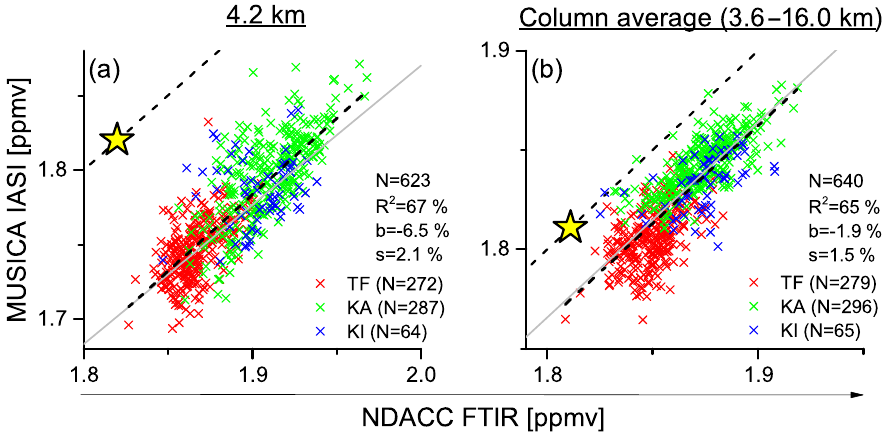
Figure 23. Correlation between daily mean MUSICA IASI and NDACC FTIR CH (cid:48) data for the L2 PPF software v6 period. Shown are the 4 data that are of particular interest for CH 4 cycle research: (a) free-tropospheric volume mixing ratios; (b) column averages between 3.6 and 16km. Red, green and blue crosses are for comparisons at Izaña and Tenerife, Karlsruhe and Kiruna, respectively. Each plot gives the number of data ( N ), the correlation coefficients ( R 2 ), the bias ( b ), and the scatter ( s ) of the differences. The thin dashed dark line is the one-to-one diagonal, the grey line the diagonal shifted by the bias value and the thick black dashed line the regression curve obtained from a linear least squares fit on all data